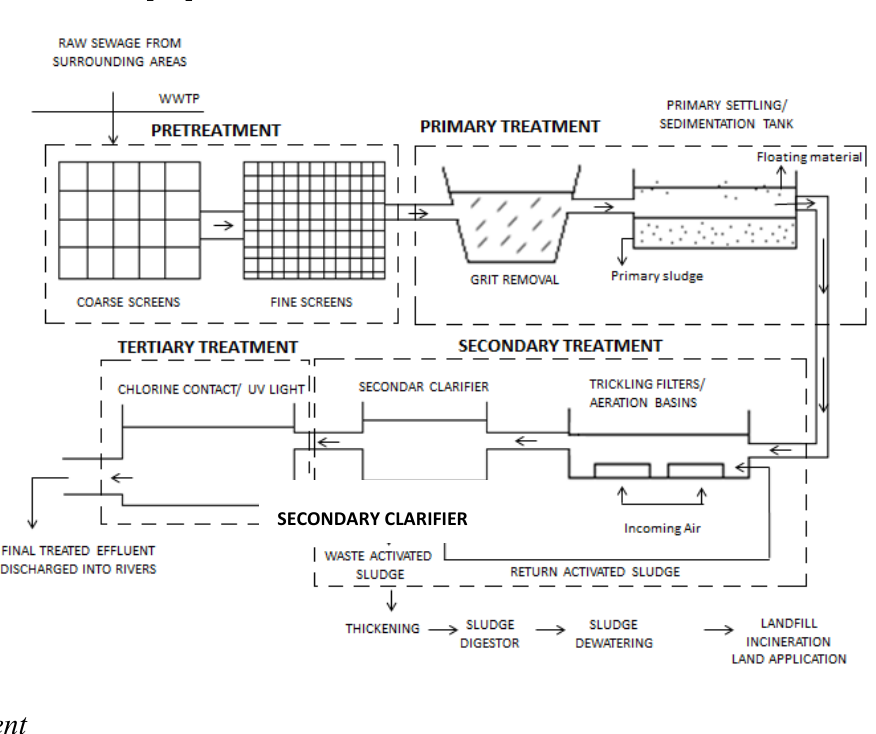
Figure 1. Overview of treatment stages within a wastewater treatment plant. Adapted from EPA [16] and UNEP